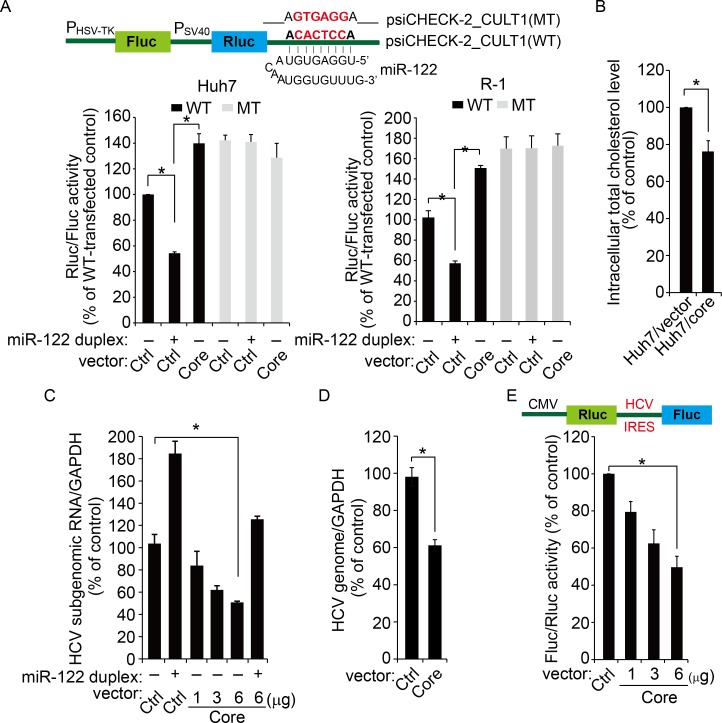
Dysregulation of miR-122 function by the HCV core protein.(A) Schematic representation of a reporter plasmid carrying a miR-122 target site [psiCHEK-2_CULT1(WT)] or a miR-122 mismatched target [psiCHEK-2_CULT1(MT)] at its 3′-UTR (top). Huh7 or R-1 cells treated with miR-122 duplexes were transfected with each indicated reporter plasmid together with pcDNA3.1 (Ctrl) or pcDNA3.1-Flag-core (Core). At 48 h post-transfection, cells were harvested, and normalized luciferase activity (Rluc/Fluc) compared with empty vector-transfected control was measured (bottom). *P < 0.005. (B) Intracellular total cholesterol content. The cholesterol content in core-expressing cells (Huh7/core) was 76.5 ± 5.1% of the Huh7/vector control. *P = 0.0013. (C) R-1 cells transfected with the pcDNA3.1-Flag-core (Core) or empty vector (Ctrl) were treated with miR-122 duplex. The HCV subgenomic RNA titer was determined 2 days after transfection by real-time qRT-PCR, normalized with GAPDH, and expressed as a percentage of that in empty vector-transfected control cells. *P = 0.0032. (D) Huh7 cells pre-transfected with pcDNA3.1 (Ctrl) or pcDNA3.1-Flag-core (Core) plasmids were infected with HCV prior to the quantification of the HCV RNA titer by qRT-PCR 2 days later. *P = 0.0011. (E) Huh7 cells were transfected with increasing amounts of pcDNA3.1-Flag-core (Core) or empty vector (6 μg; Ctrl) together with a dual luciferase reporter expressing Renilla luciferase (Rluc) and firefly luciferase (Fluc) by cap- and IRES-dependent translation (top), respectively, before dual luciferase assays at 48 h post-transfection. *P = 0.0022. For all panels, error bars are standard deviations of three independent experiments, each involving triplicate assays. P values were calculated using an unpaired t-test.